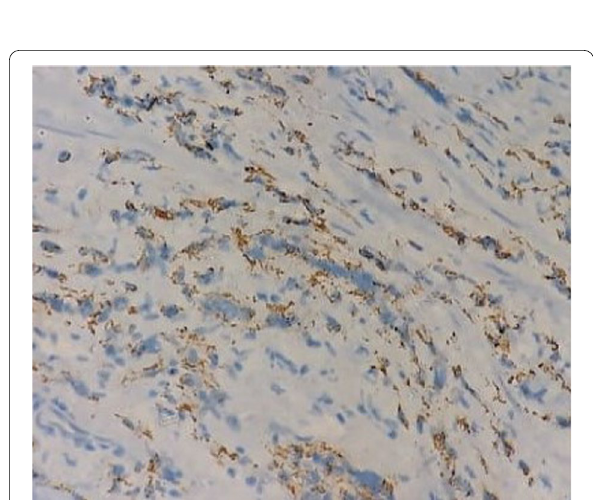
Fig. 4 Immunohistochemical marker AE1/AE3 shows positive staining of the tumour